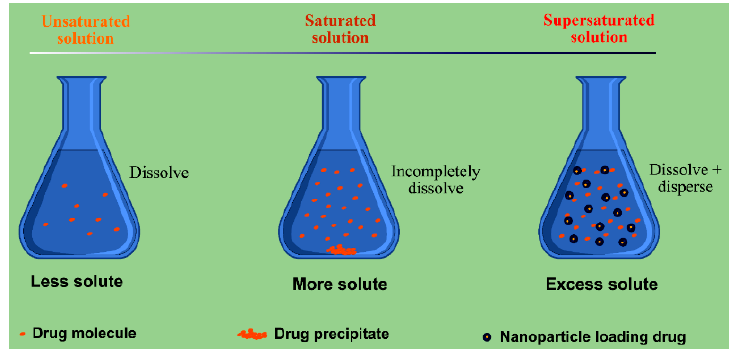
Figure 4. Schematic illustration of supersaturated state of drug in nanoparticle dispersion system.